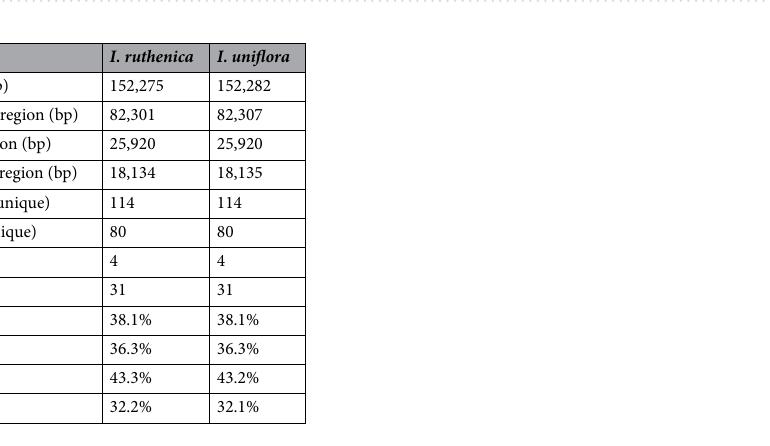
Figure 4. Circular gene maps of Iris ruthenica and I. uniflora plastomes . Genes drawn inside the circle are transcribed clockwise, and those outside the circle are transcribed counterclockwise. The darker gray in the inner circle represents GC content.